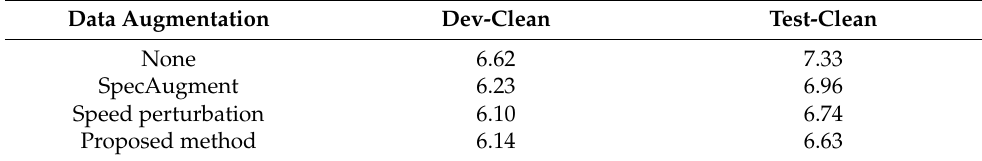
Table 7. WER (%) results of LibriSpeech database according to data augmentation methods.